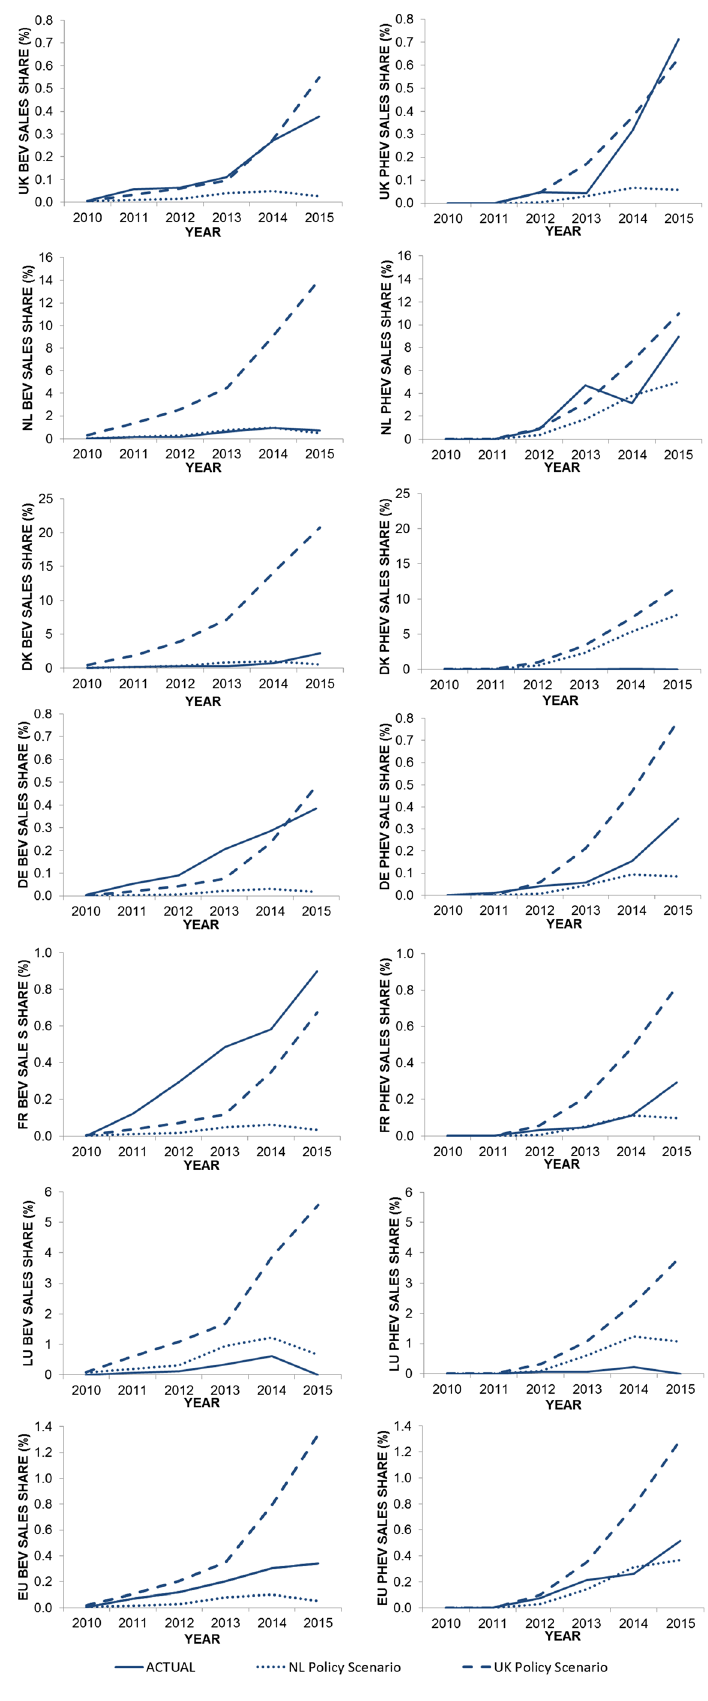
Fig. 6 PiEV sales shares in the EU, case study countries (UK and NL) and selected comparative countries (DK. DE, FR, LU) under NL and UK policy scenarios determined in the case studies (NL_14 and UK_11) and actual sales (2010-14 [23] adapted by [16];